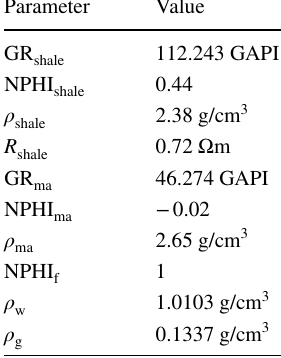
Fig. 4 Horner plot of bottom-hole temperature; where markers (black circles, red triangles, blue diamonds, and magenta crosses) are maxi- mum well recorded temperature at depths shown, and solid lines are logarithmic least-squares fit to the data. At least three maximum ther- mometer records of the logging tool are preferable to extrapolate for- mation temperature using the Horner plot